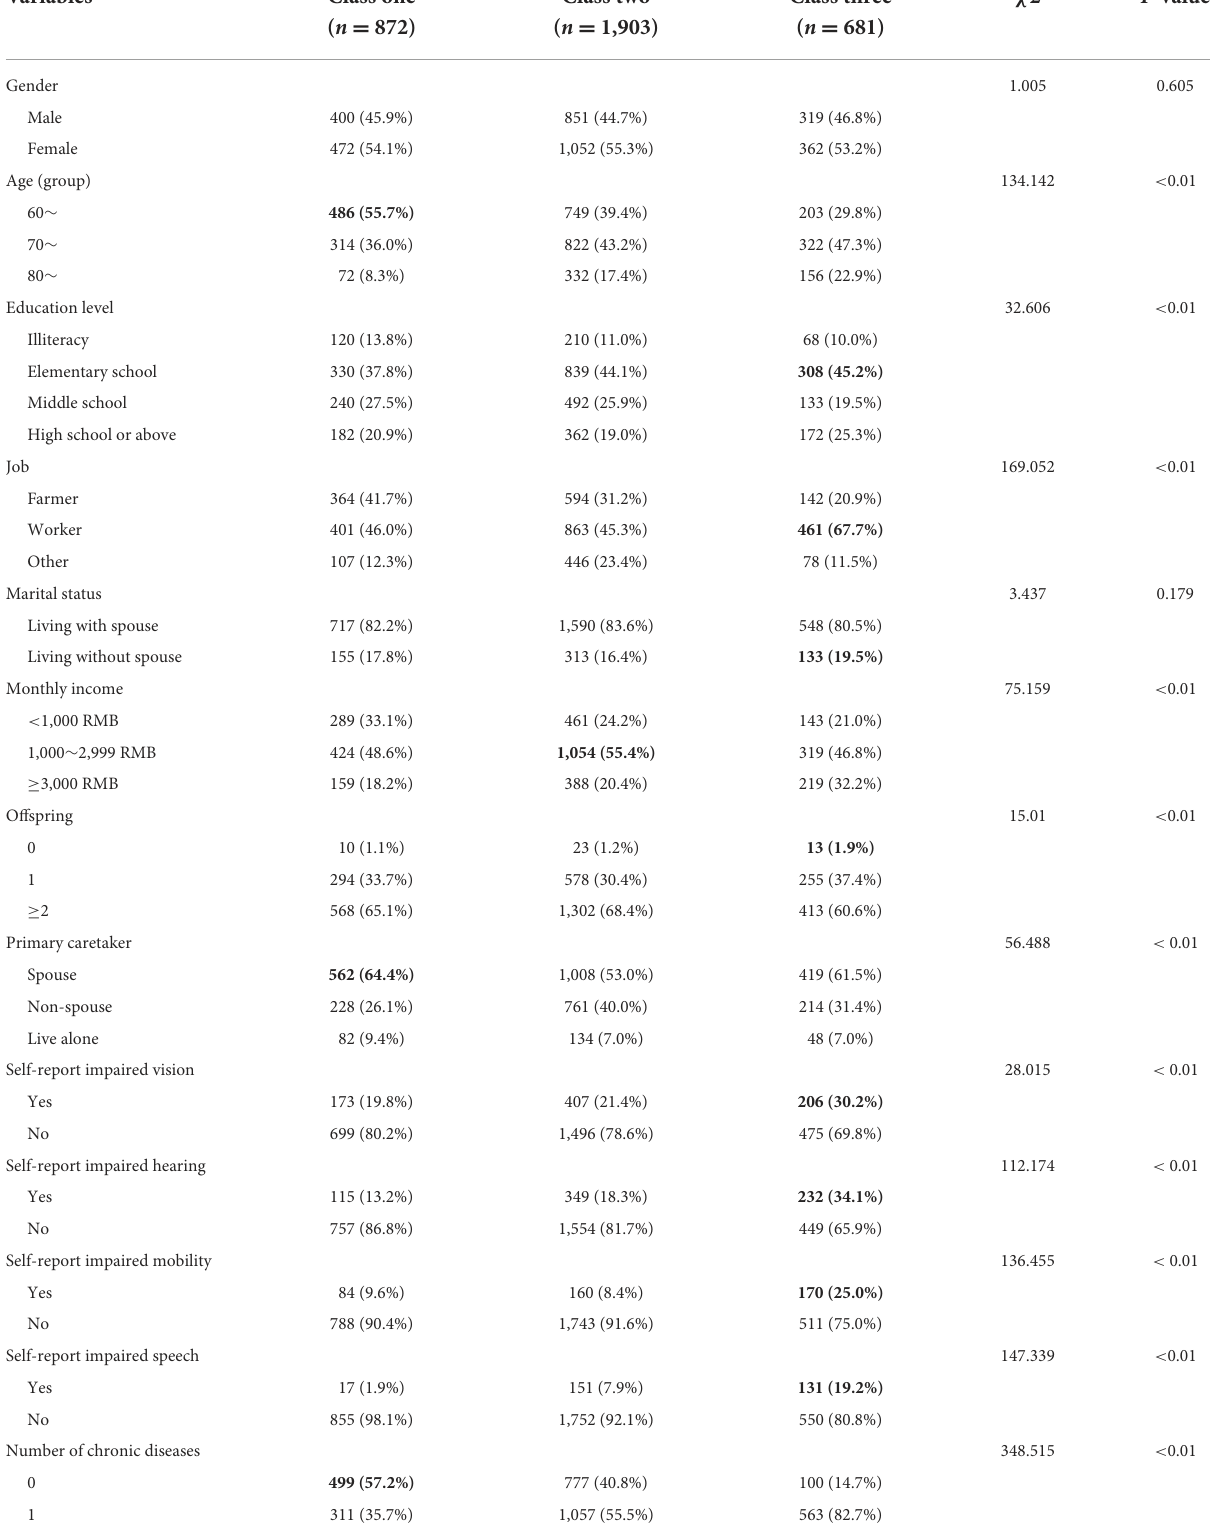
TABLE 4 Characteristics of individuals in different potential groups based on participation level by the latent profile analysis ( n =